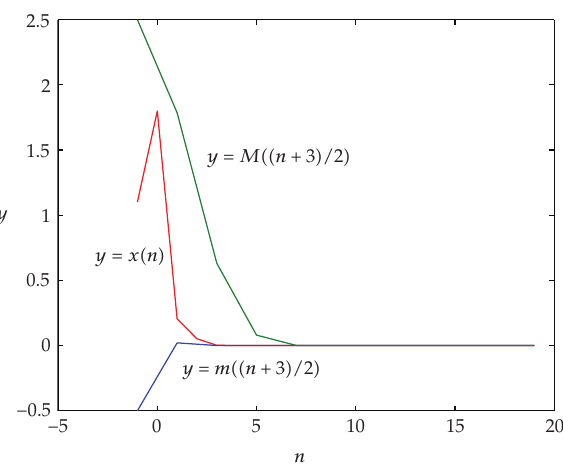
Figure 1: Chart of (cid:5) 4.1 (cid:6) with x (cid:5) − 1 (cid:6) (cid:4) 1 . 2 , x (cid:5) 0 (cid:6) (cid:4) 1 . 8 .